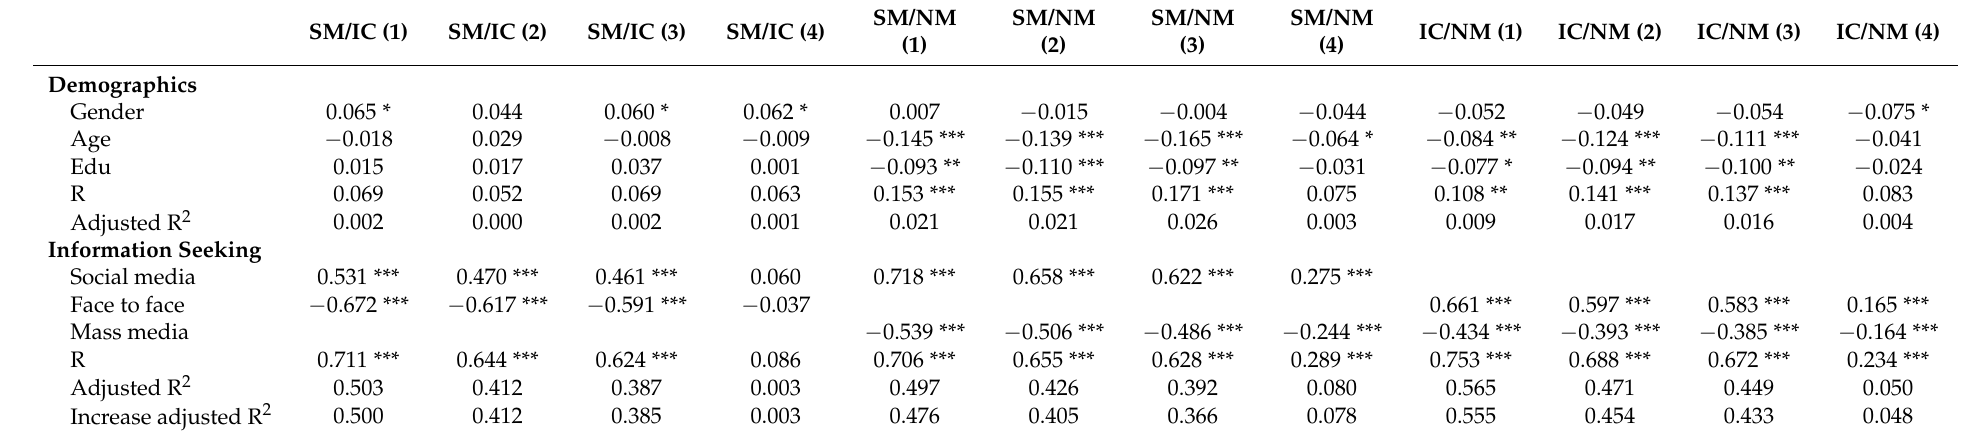
Table 6. Individual superiority scores and replacement